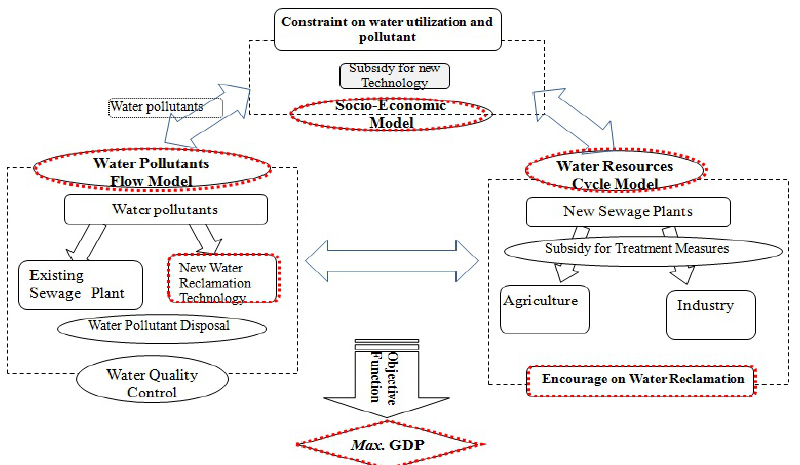
Figure 1. Implementation of the integrated dynamic